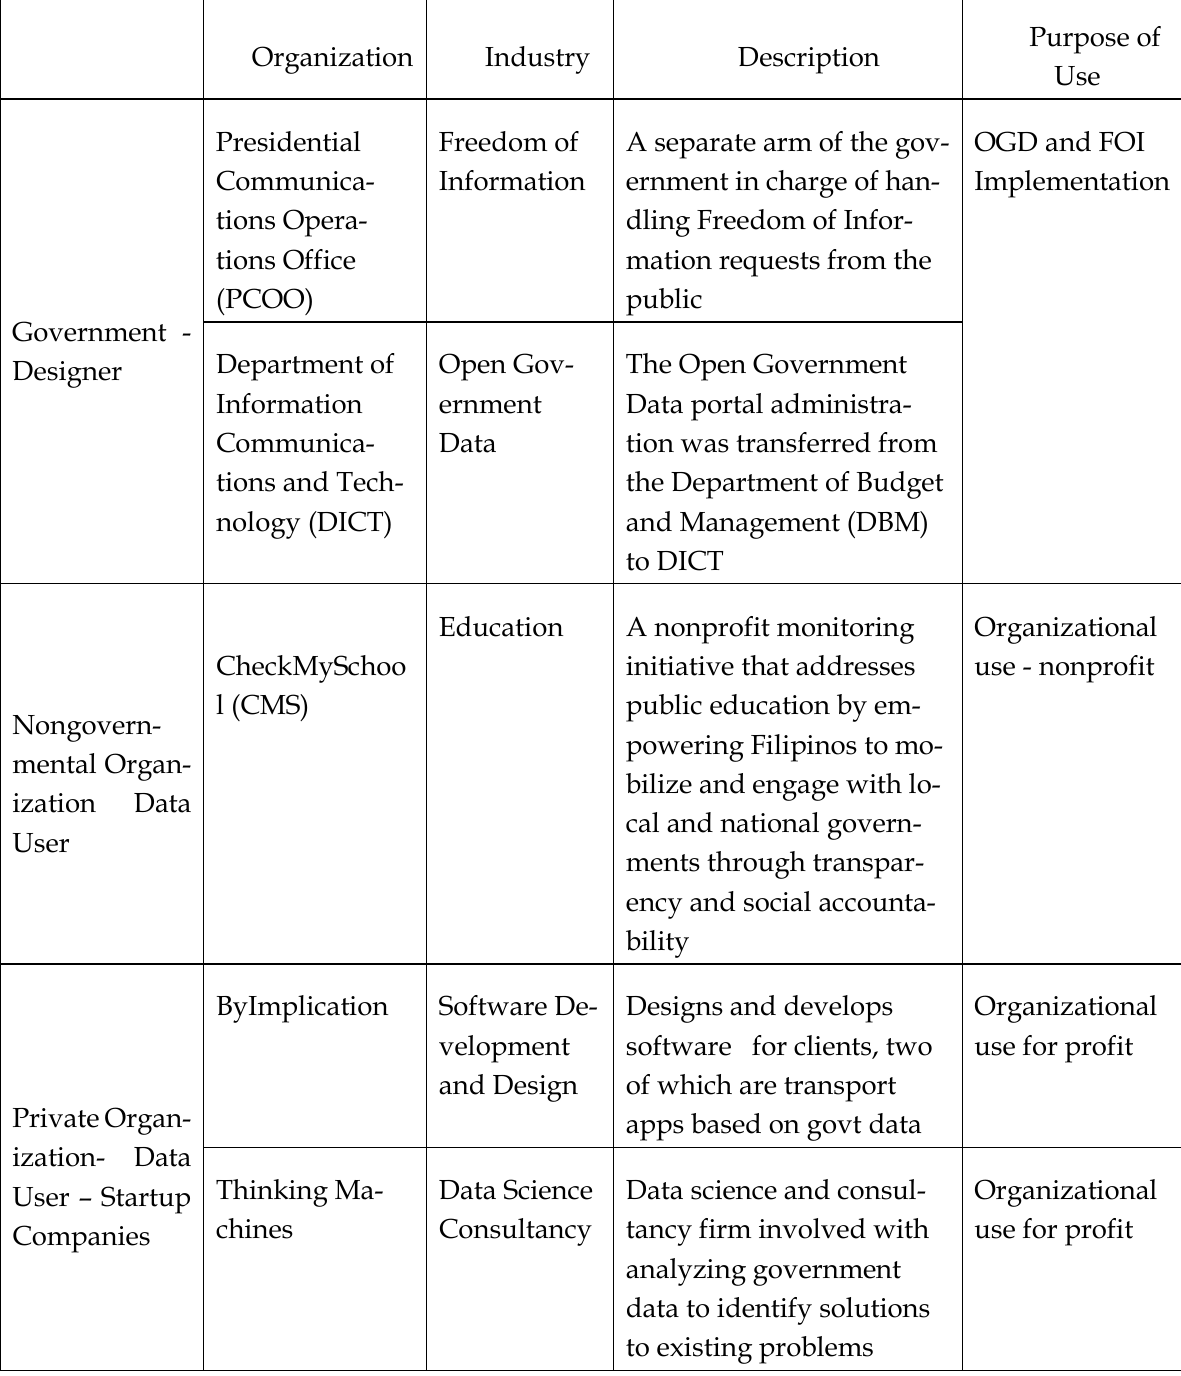
Table 4: Summary of Open Government Involvement per